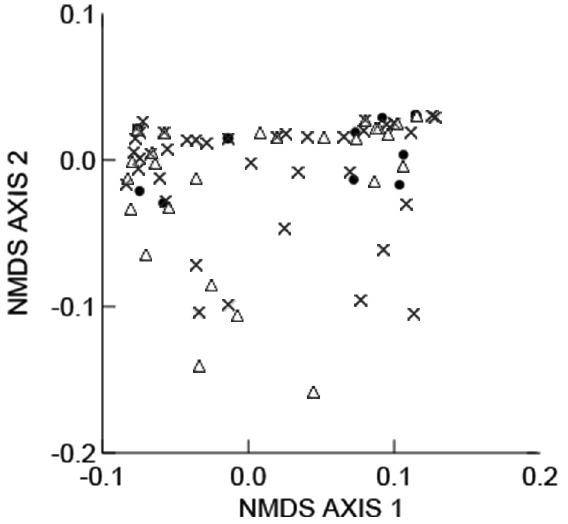
Figure 3 - Multidimensional scaling analyses of the diet composition in individuals of Phyllodytes luteolus from Setiba (empty triangles), Guriri ( fi lled dots) and Prado (“X”). Stress =